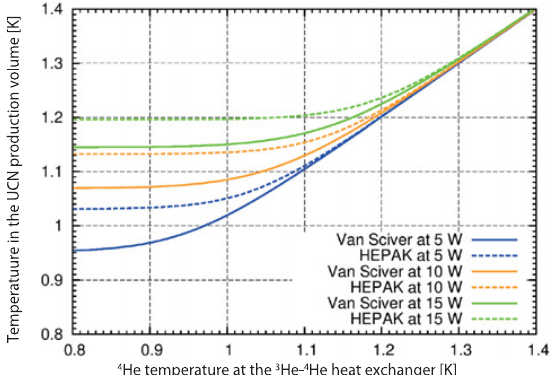
Figure 8. Temperature in the UCN production volume as a function of the superfluid-helium temperature at the 3 He − 4 He heat exchanger, for various heat loads using f ( T ) − 1 derived from Van Sciver [5] and HEPAK [9]. The UCN guide diameter is 150 mm and its length is 1.5m.